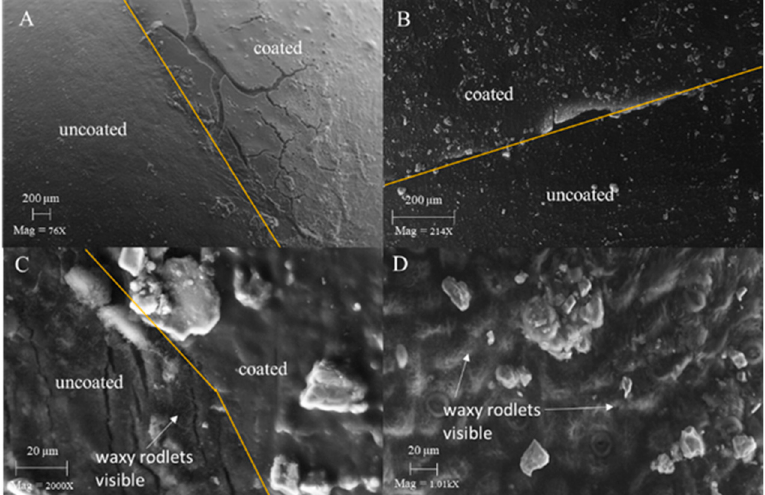
Figure 3. SEM images of blueberries with only one half of the fruit coated ( A – C ) or fully coated ( D ) to help better understand coating effects. Carnauba (CAR) coating illustrating the propensity of this coating to crack ( A ). Two magnifications of the chitosan (CH) coating ( B , C ) showing its appearance in contrast to the uncoated portion of the fruit. An image of blueberry treated with acetic acid (1%), the control for CH, is shown in a treated area of the berry ( D ).